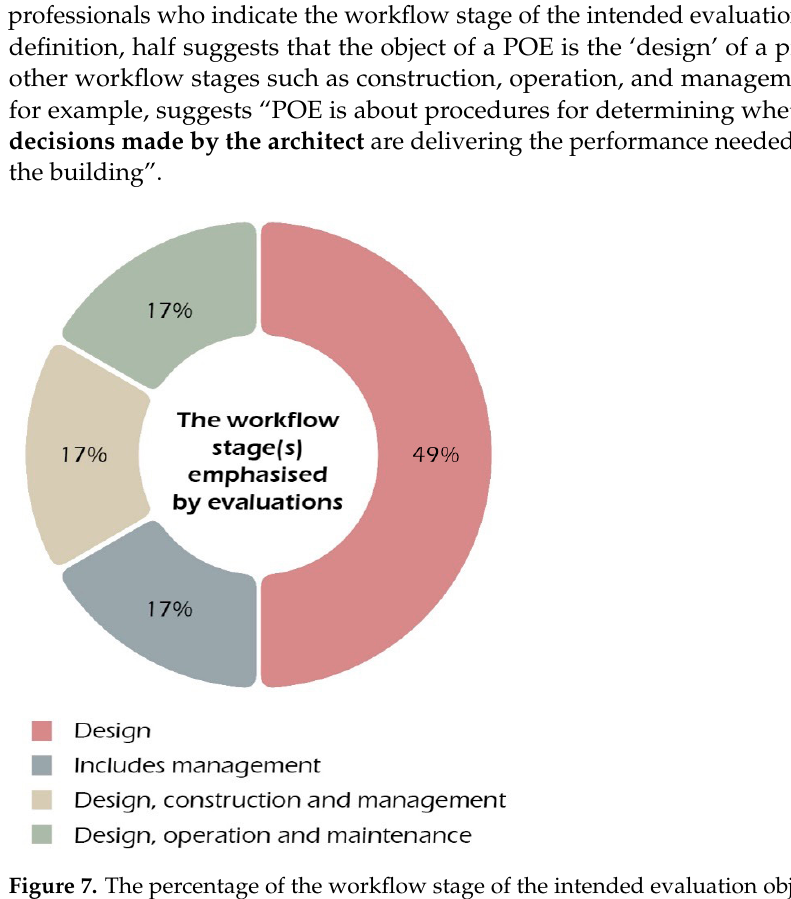
Figure 7. The percentage of the workflow stage of the intended evaluation object indicated by the collected definitions.